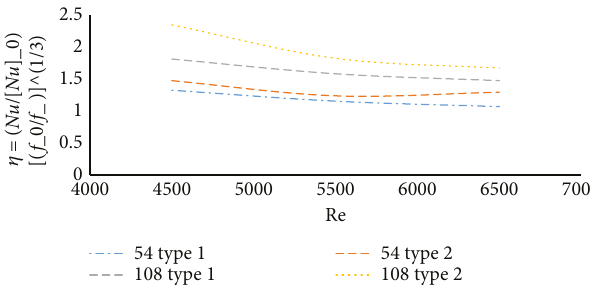
Figure 12: Thermal enhancement factor η for varying Reynolds